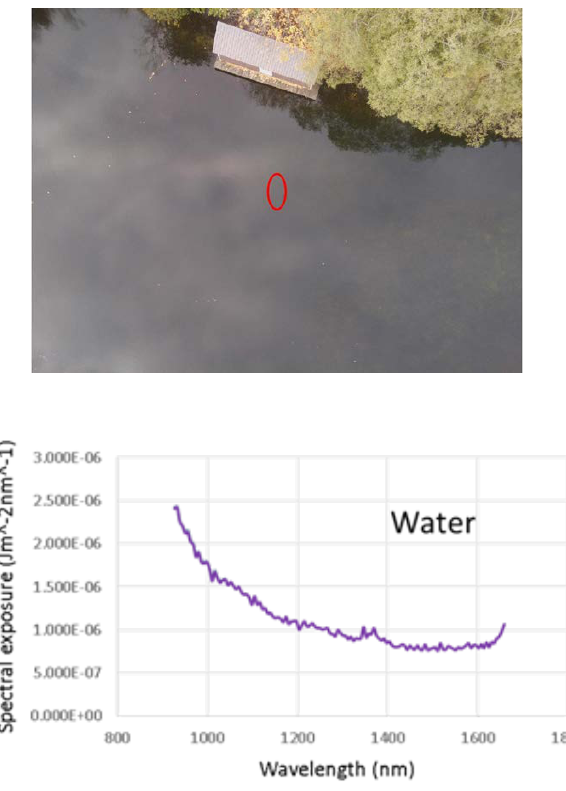
Figure 8. Spectral exposure of water based on the spectrometer’s footprint ellipse.